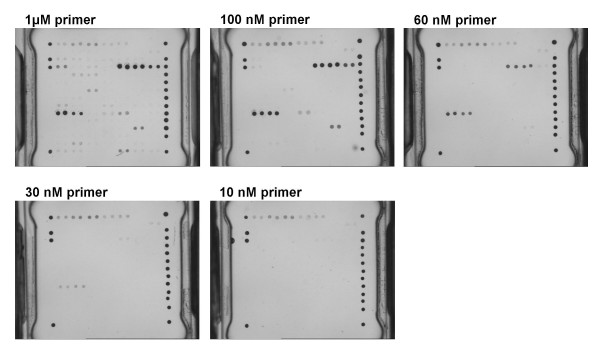
Dependence of signal development on primer concentration. ds-cDNA was generated from 0.6 μg total RNA of DLD-1 at 62°C by linear amplification using the primer mix for Matriptase, PAI-1 and PAI-2. Different primer concentrations are indicated. Hybridization to the Array tubes® in accordance to the protocol described in the Methods part.